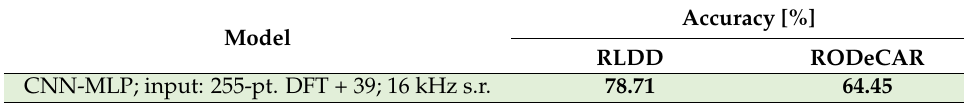
Figure 11. RLDD and RODeCAR; final CNN-MLP-based VAD, with expanded frequency-domain input (255-pt. DFT at 16 kHz sampling rate), retrained on 10% of the data: accuracy vs. ∆ t ext . Table 5. Final CNN-MLP-based VAD utterance-level test performance–RLDD and